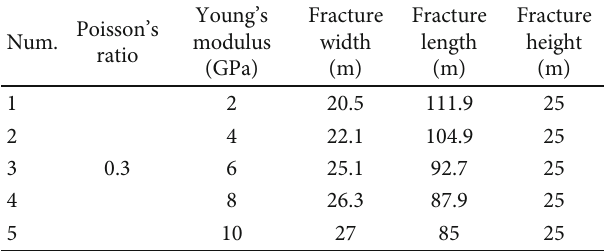
Table 2: Fracture extension scales under di ff erent Young ’ s moduli.